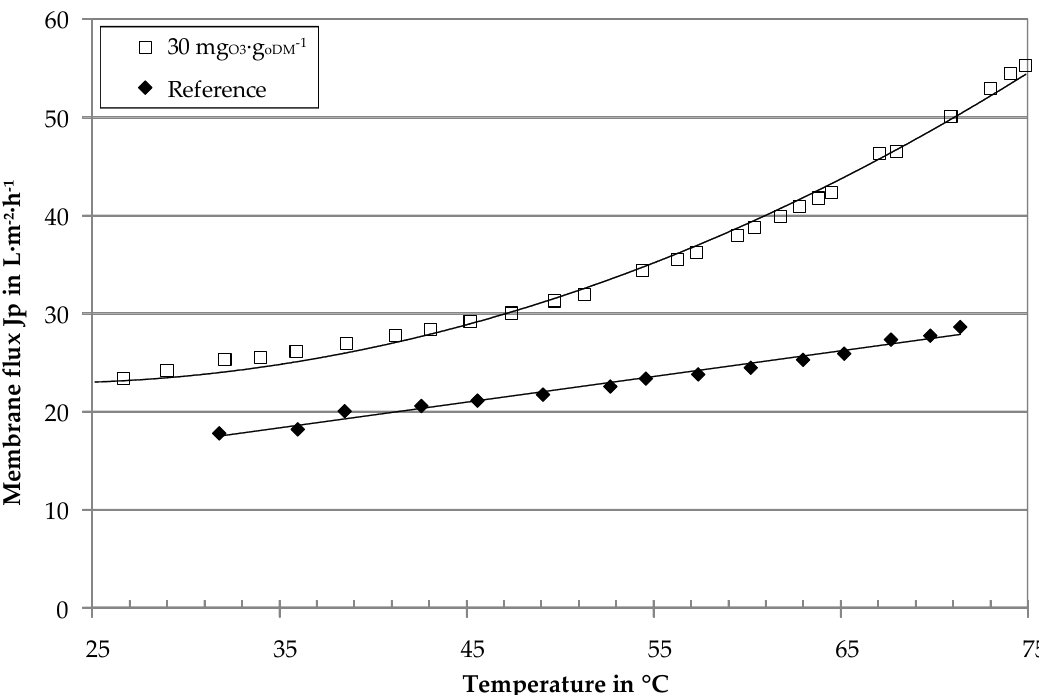
Figure 7. Membrane flux of digestate centrates (pilot plant at BP I) with ozone treatment and without (reference) as a function of temperature, ∆ p = 4.02 ± 0.05 bar, v = 4.6 ± 0.4 m · s − 1 , 70% recovery. The gradient for the ozone-treated sample in Figure 7 increases for temperatures above 45 °C. Table 2. Mean rheological parameters of digestate centrate with and without ozone